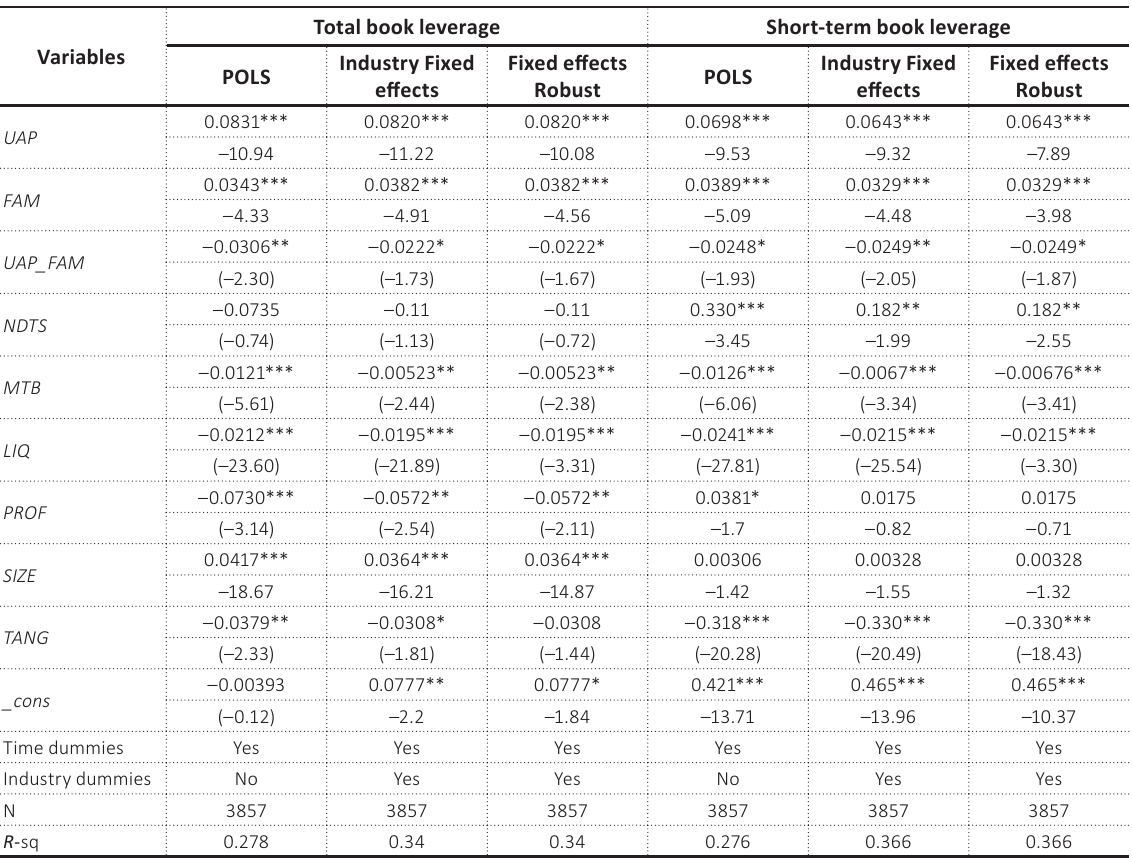
Table 5. POLS and Fixed effects